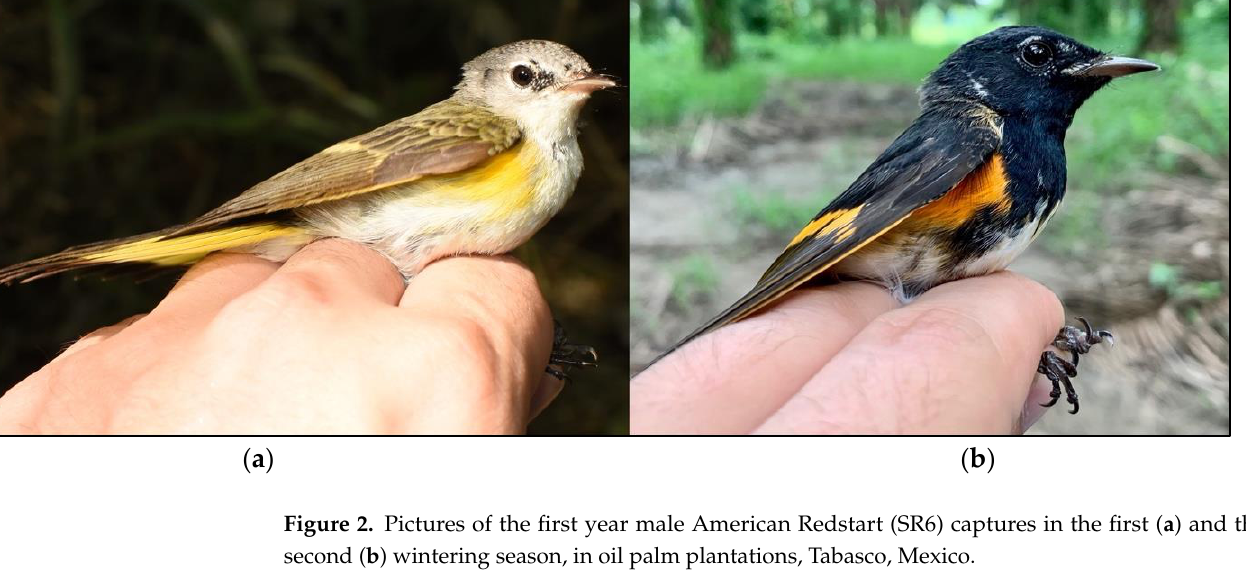
Figure 1. Boxplot of mean showing territory size of American Redstarts ( Setophaga ruticilla ) in oil palm plantations and in native forest in Tabasco, Mexico. Lines represent, in bottom-up order: minimum, first quartile, median, third quartile, and maximum.